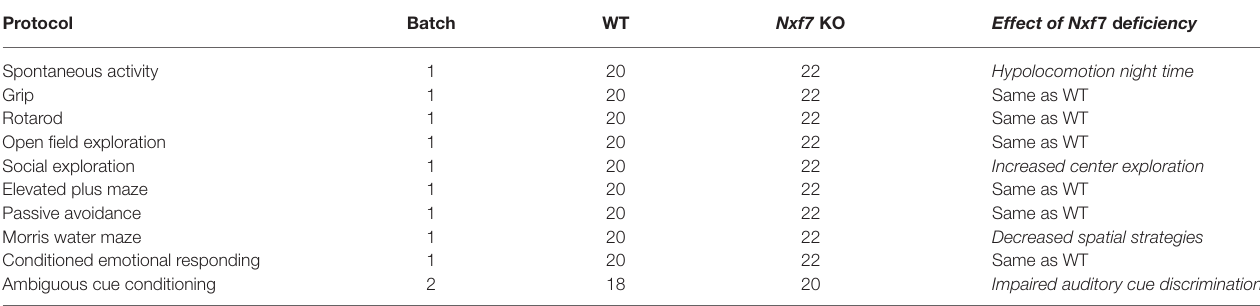
TABLE 1 | Overview of behavioral tests, number of animals tested and summary of behavioral observations.